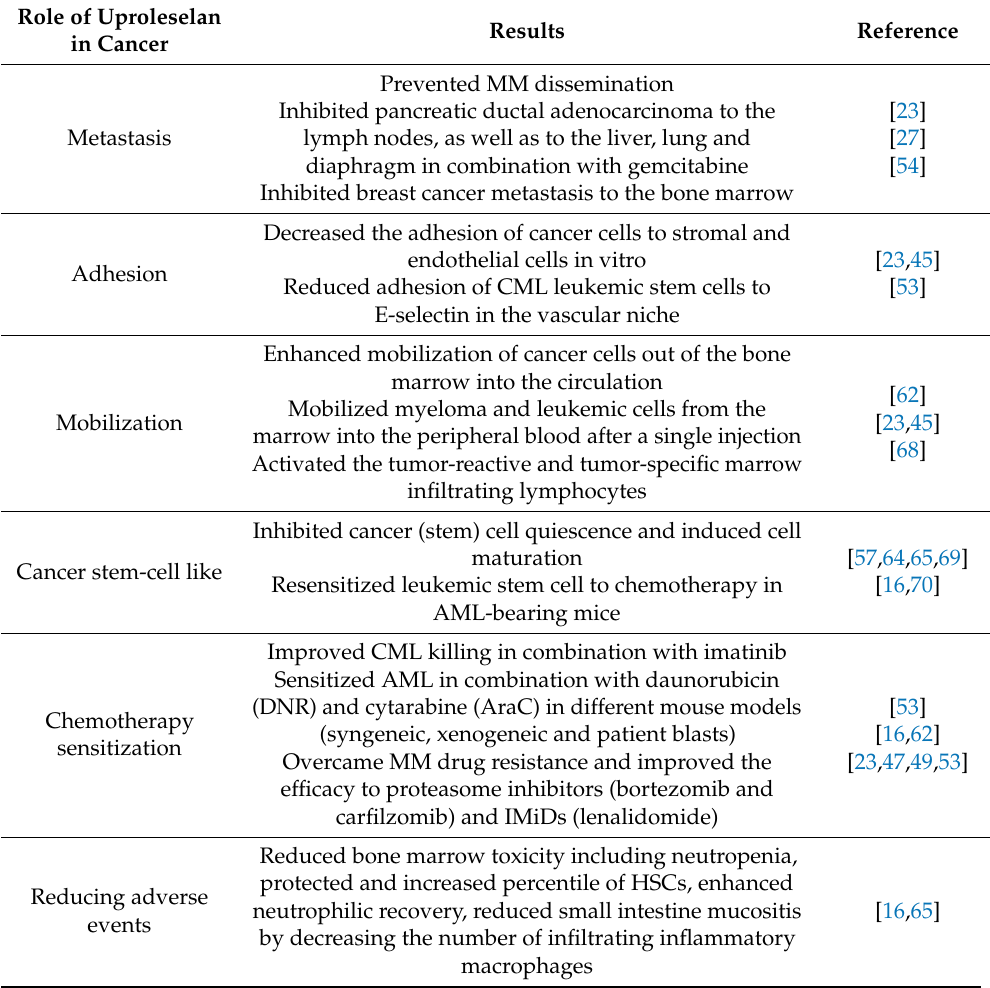
Table 3. Role of uproleselan in preclinical cancer